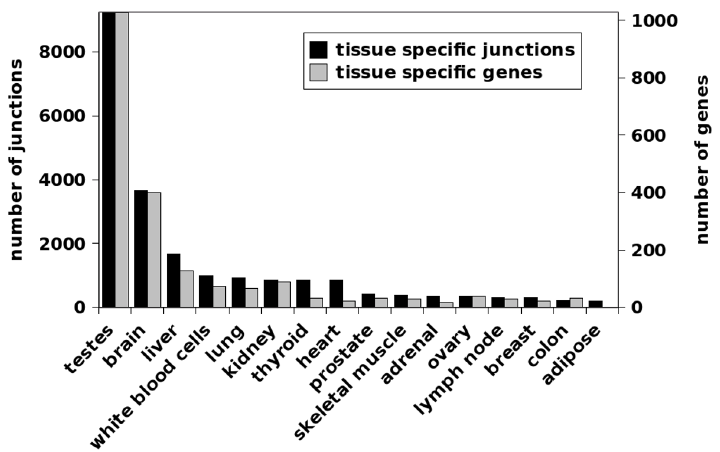
Fig 5. The number of splice junctions and genes specific to each tissue. Maximum values of the y-axis are set to the number of junctions/genes found in testes (9,234 splice junctions and 1,028 genes).